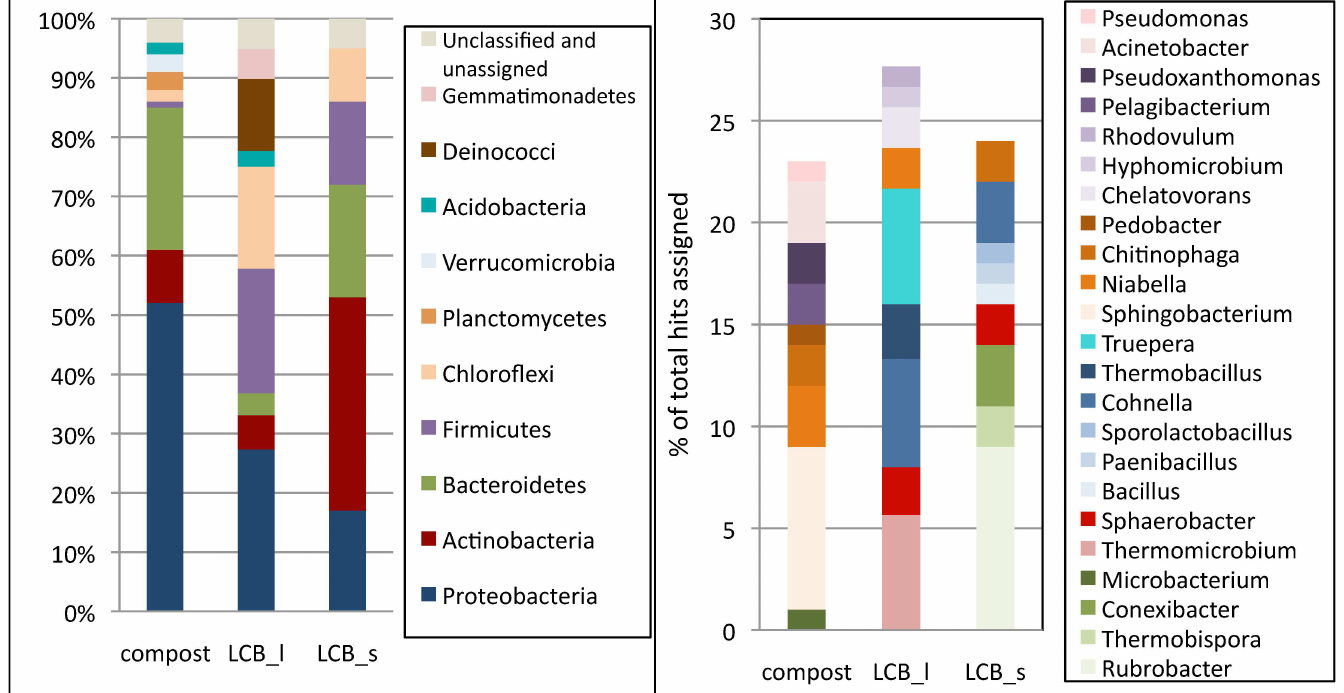
was lower in the LCB_l culture, but slightly higher (or about the same) in the LCB_s enrich- ment (6.6 / 100 kb). Over 600 sequences attributed to a glycoside hydrolase family were identi- fied in the initial compost sample. When hit numbers were normalized by the total sequenced volume, the number of glycoside hydrolases (based on assembled sequences) did not change significantly in the LCB_s culture compared to the initial compost. There were about three times less glycoside hydrolases in the LCB_l enrichment, however, compared to the CI sample (Table 4 and S3 Fig). Upon closer inspection, 29 glycoside hydrolases assigned to families from which cellulase activity has been reported (families GH5, GH6, GH9, GH12, GH45, GH48 and